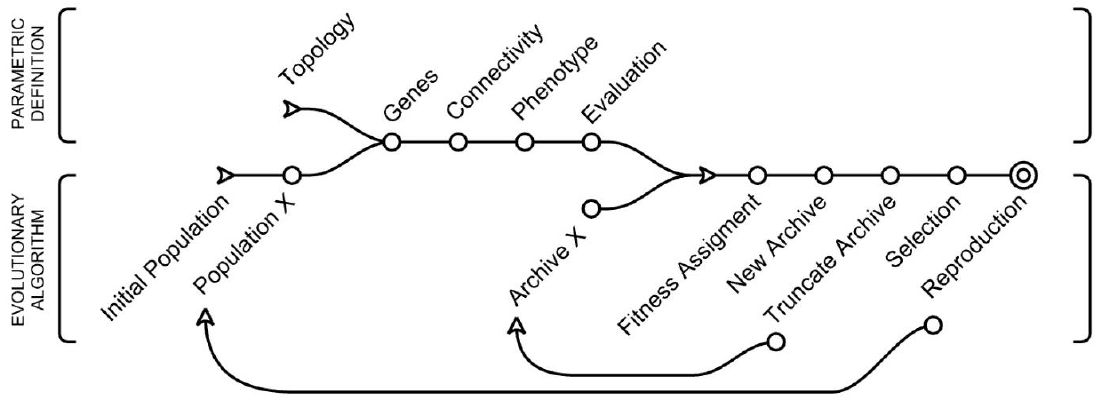
Figure 4. Workflow diagram explaining the combination between parametric modeling and evolutionary algorithm (EA).